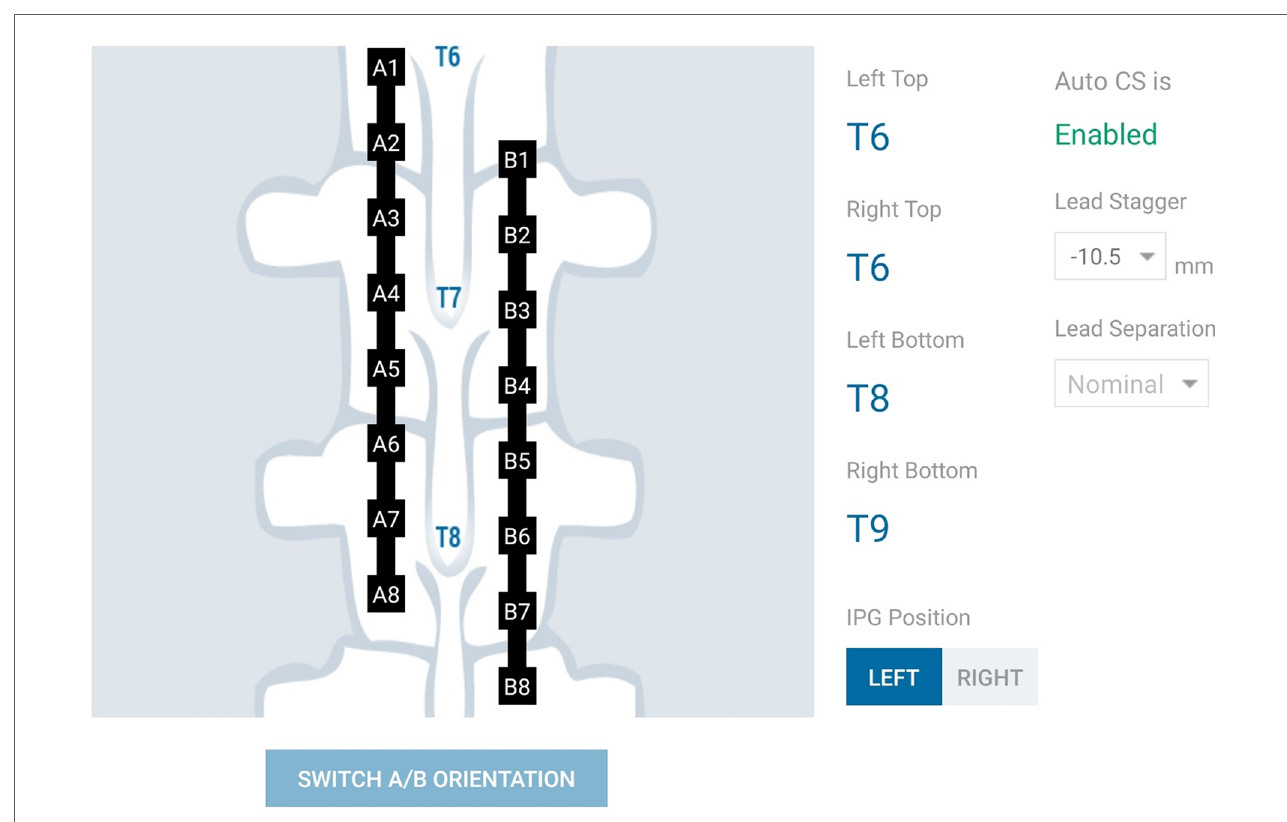
FIGURE 4 Schematic representation of lead con fi